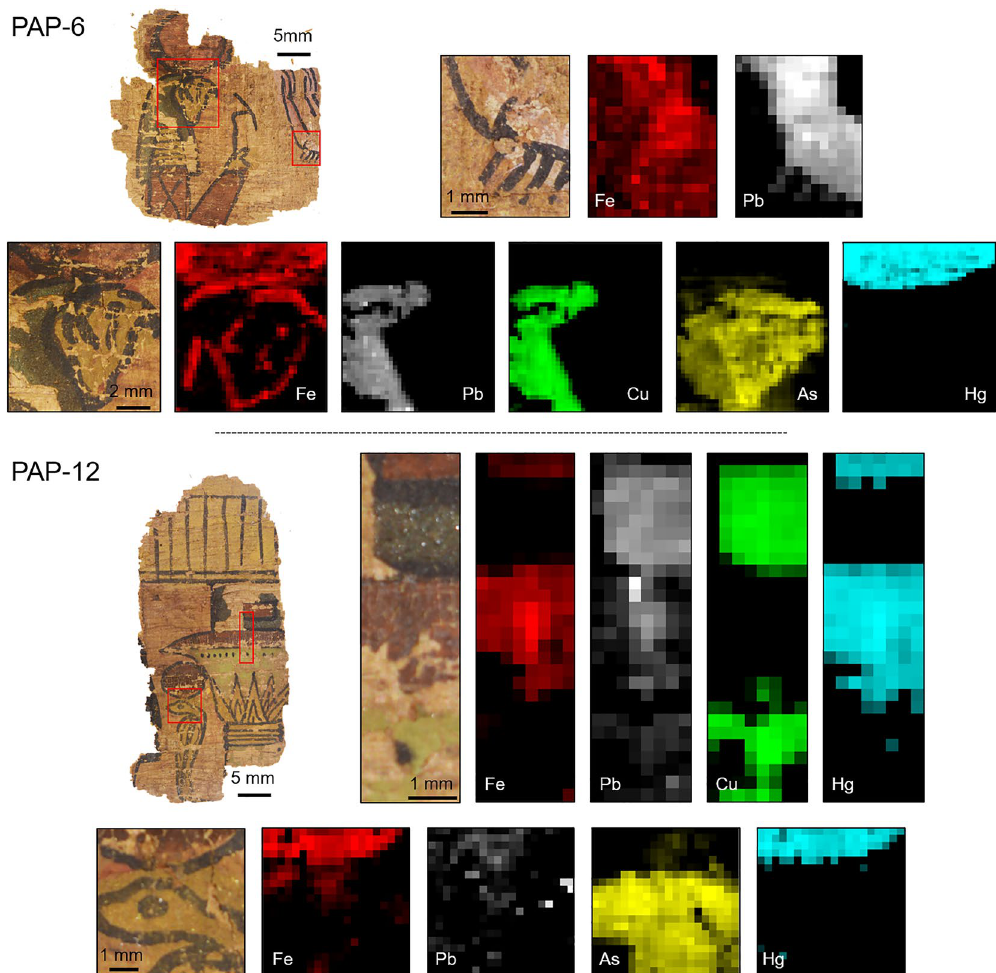
Figure 2. X-ray fluorescence maps recorded on PAP-6 and PAP-12. Data were normalized to the incident X-ray flux, and for each of the maps, the brightest pixel corresponds to the highest amount of the selected chemical element (logarithmic scale, arbitrary